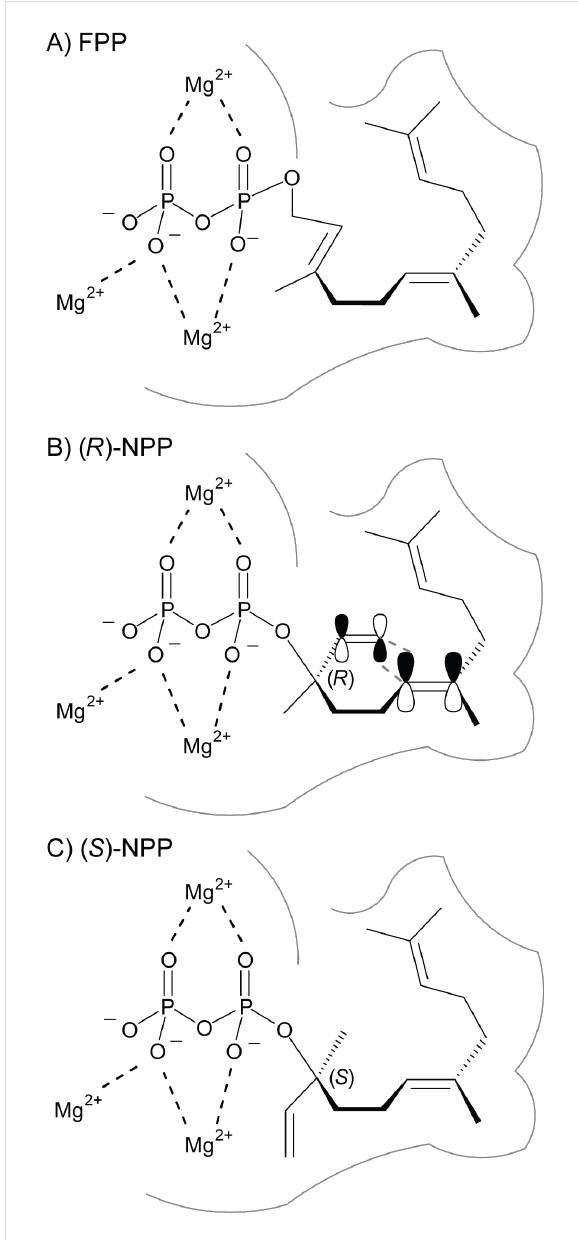
Figure 4: Hypothetical BbS active site comparable conformational folds of A) FPP, B) ( R )- and C) ( S )-NPP explaining the selective forma- tion of 5 from ( R )-NPP by ring closure via ( S )- A and of 1 from ( S )-NPP by hampering ring closure leading to